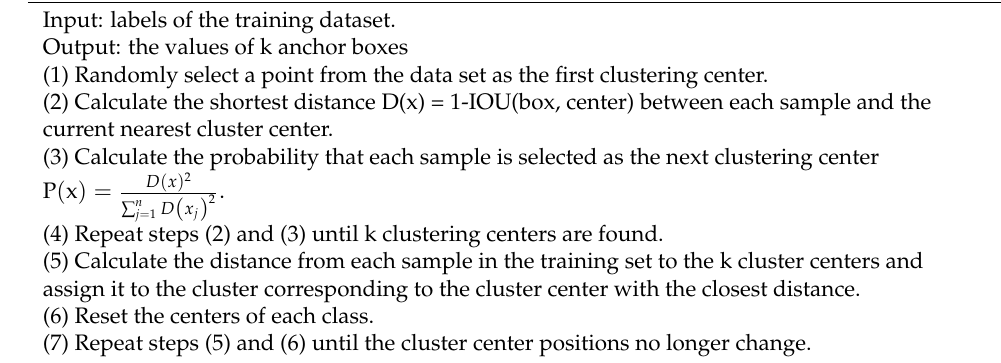
Algorithm 1 Steps of the K-means++ Clustering